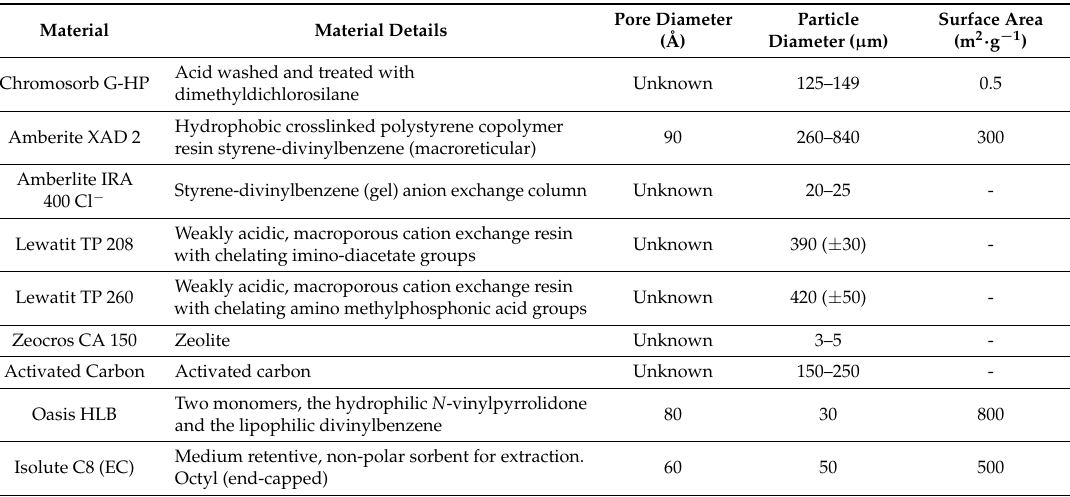
Table 1. Physical properties and structural characteristics of tested